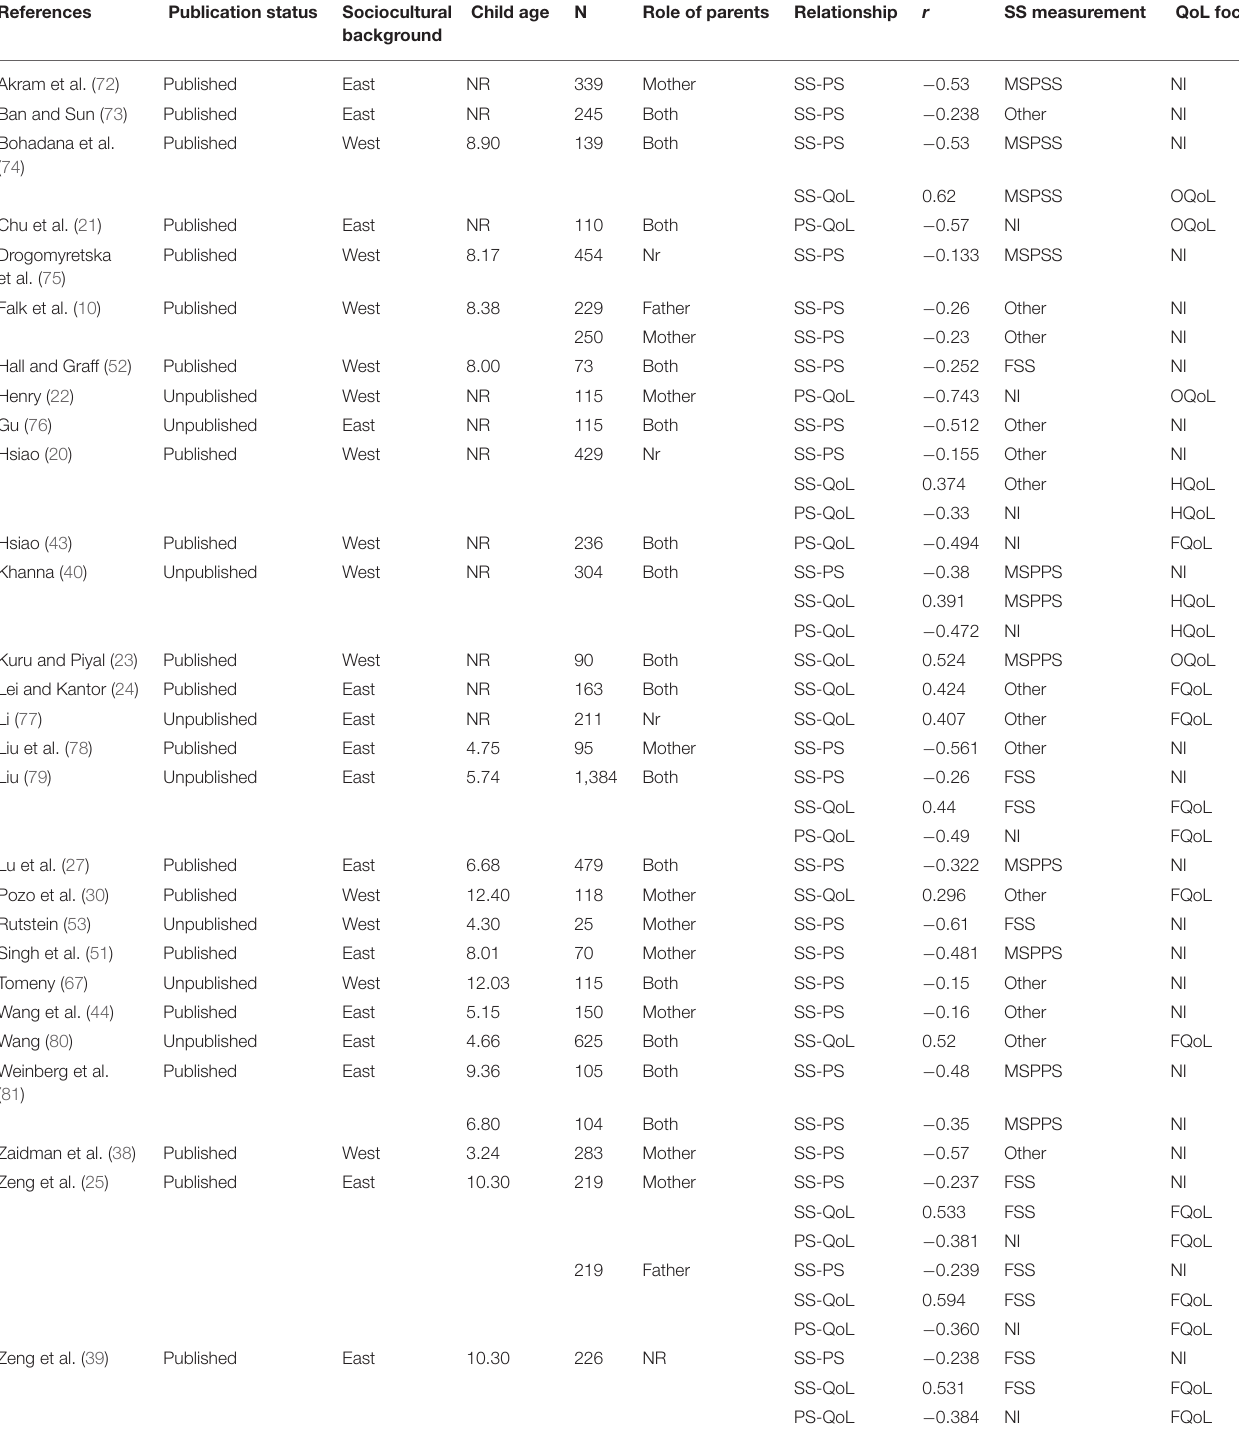
TABLE 2 | Basic information from the original studies for the meta-analysis